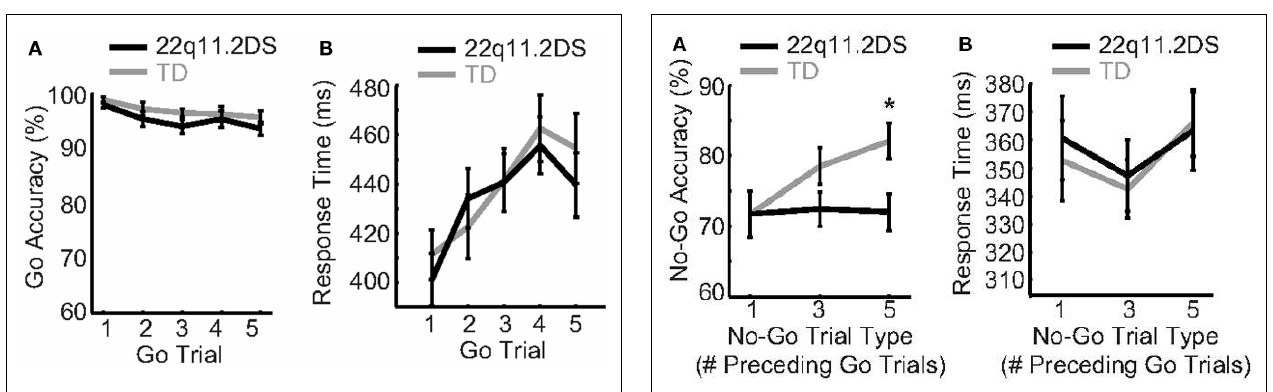
FIGURE 3 | Reactive response inhibition was atypical in children with 22q11.2DS . (A) TD children demonstrated better No-Go accuracy as a function of more preceding Go trials, while children with 22q11.2DS did not demonstrate this pattern. (B) There were no group differences in response time on incorrect No-Go trials (false alarms).